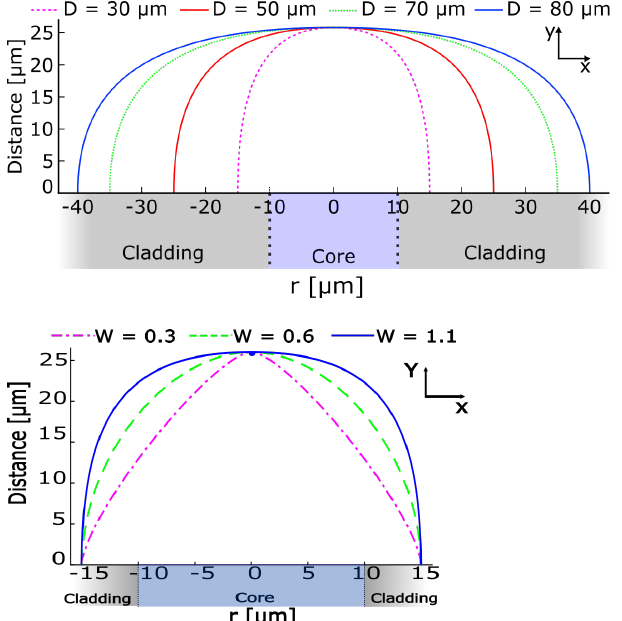
Figure 1. Tip shapes representation. Height h = 26 µm. ( Top ) W 0 = 1.1, and 4 base diameters D: 30 µm, 50 µm, 70 µm, 80 µm and ( down ) D = 30 µm and 3 Bézier weights W 0 : 0.3, 0.6, 1.1. Core diameter 2 a = 20